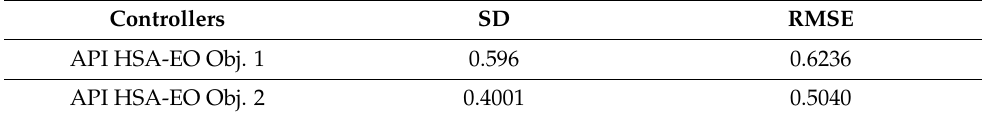
Table 16. Statistical analysis of the active power—faulty third case.